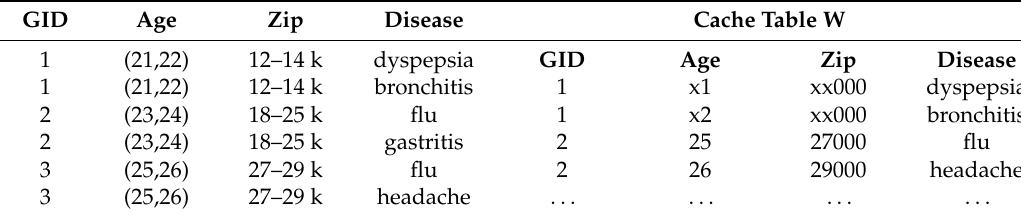
Table 5. The equivalent group and the cache table W (when t2 is